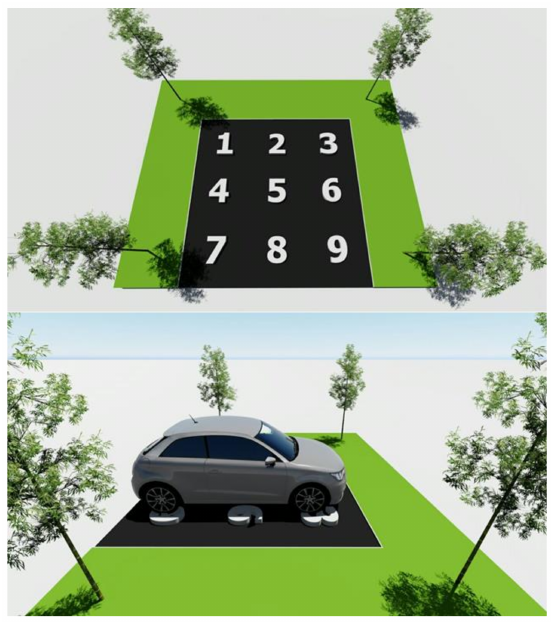
Figure 2. Numbering system for the zones in each car park bay where tests were performed and the common position of a car parked in the bay.